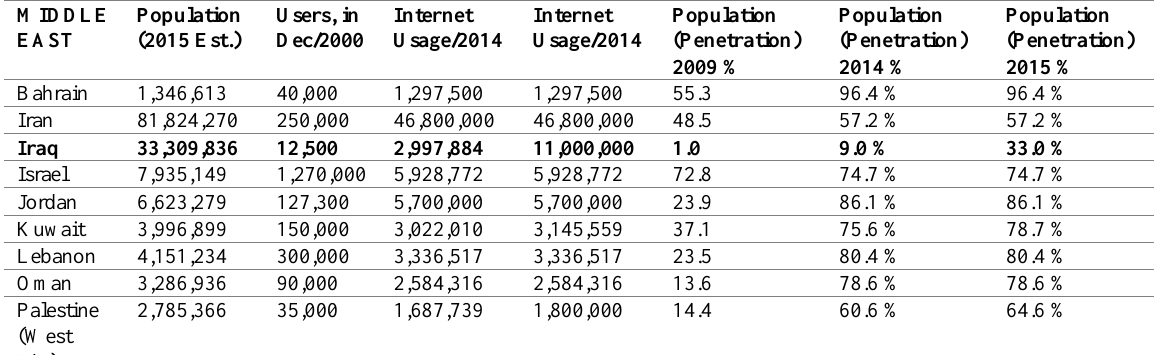
A Comparison of Internet Usage in Middle East Countries Until November 30, 2015 (Internet World Stats,